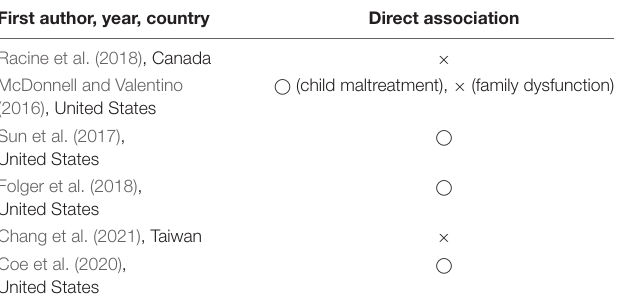
TABLE 1 | Direct effect of reviewed studies.